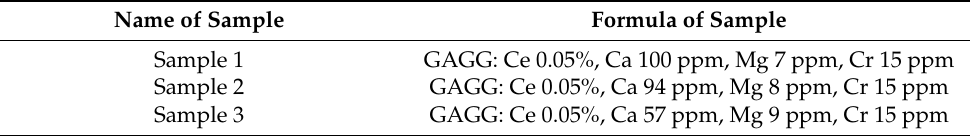
Table 1. Chemical composition of synthesized powders determined by